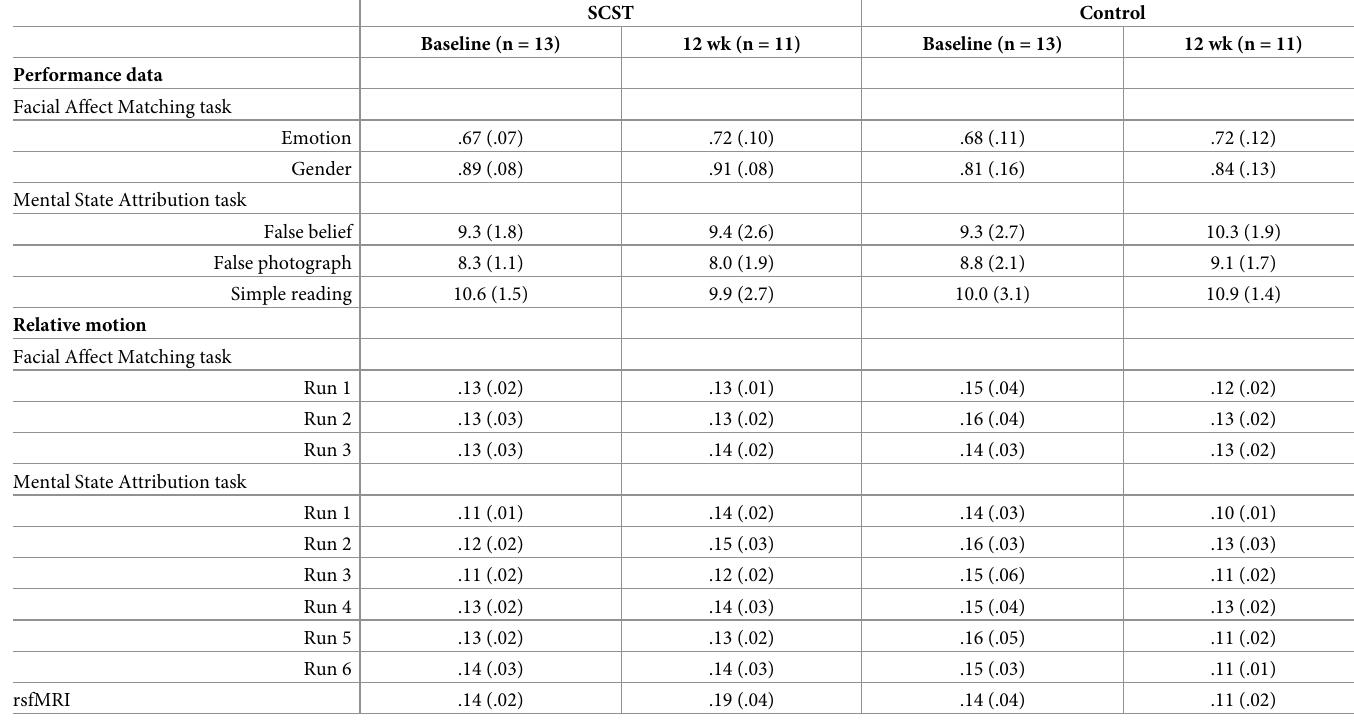
Table 2. Performance data and relative motion in the